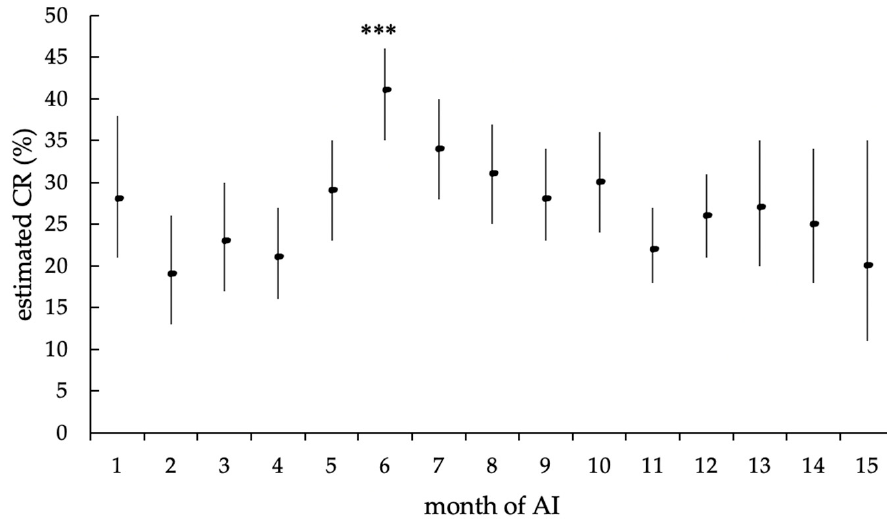
Figure 9. Estimated mean CR (in %) of the different months of AI, with upper and lower limits of the confidence interval, according to the statistical model with random effect. The estimated mean CR of the AI month (***) showed a highly significant difference from the estimated average CR ( p < 0.0001).